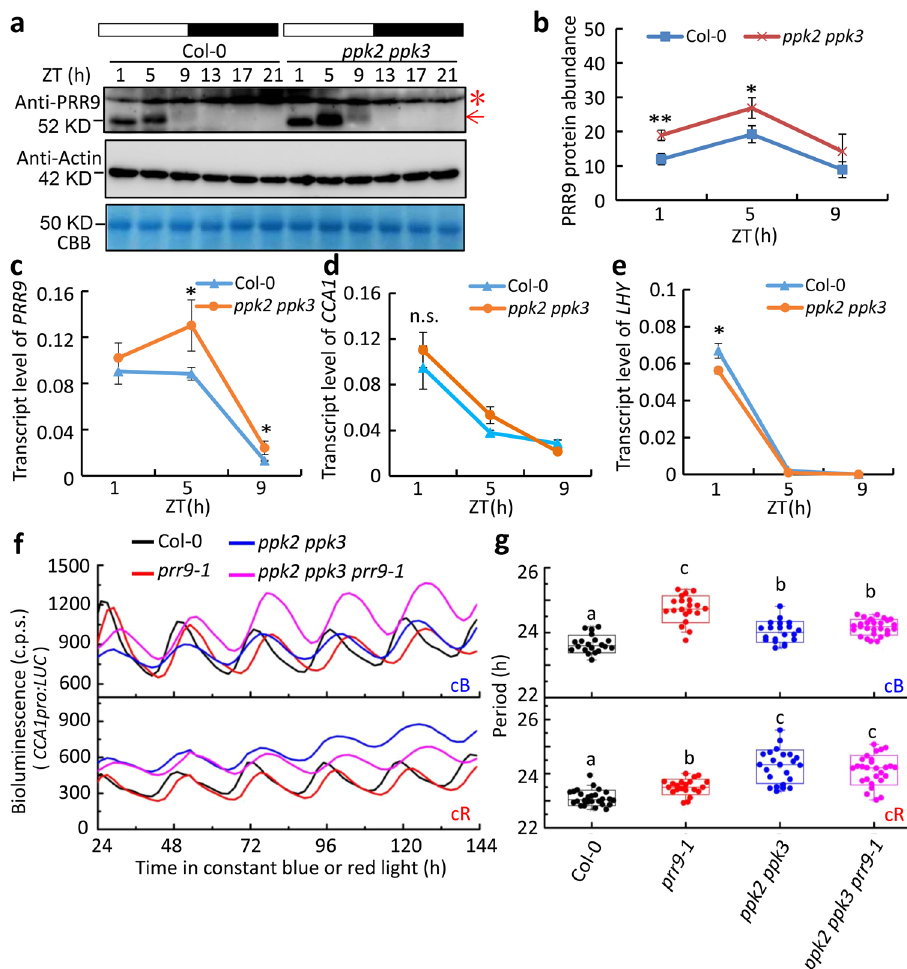
Fig. 6 | Phosphorylation is critical for both protein turnover and repressive activityofPRR9.a TemporalexpressionpatternofPRR9proteininCol-0and ppk2 ppk3 double mutants. Seedlings were grown in LD condition for 14 days and har- vestedatindicatedtimepoints.Totalproteinlysateswereanalyzedbyimmunoblot probed with PRR9 antibody indicated by a red arrow. The asterisk stands for nonspeci fi c band and the arrow indicates endogenous PRR9. Actin and CBB staining were used as loading controls. b Quantitative analysis of PRR9 protein abundanceasshownin a ,normalizedwithActin.Dataweremeans±s.d.fromthree biological replicates. ** p <0.01, * p <0.05 by two-tailed student ’ s t -test. c – e Temporal transcriptlevelsof PRR9 ( c ) , CCA1 ( d ),and LHY ( e ) from seedlings as shownin a growninLDconditions,determinedbyRT-qPCR.Dataweremean±s.d.,